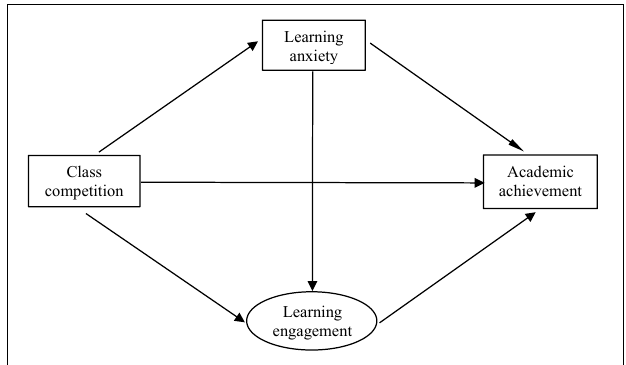
FIGURE 1 | Hypothesis model of the relation between class competition and academic